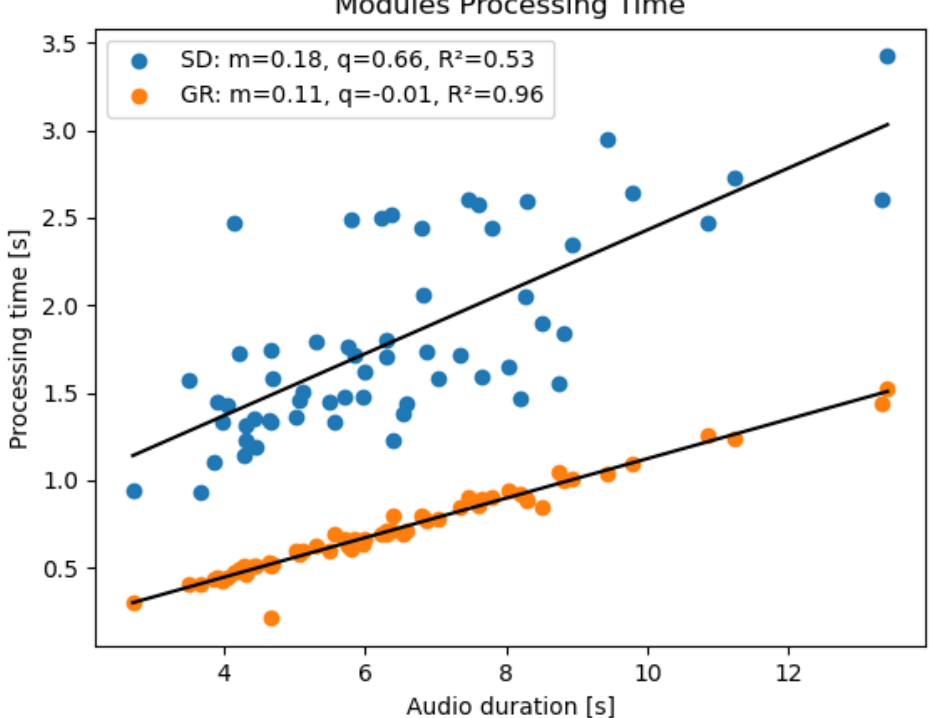
Figure 6. Processing time of the Speech Detector (blue) and Gender Recognition (orange) modules executed on Raspberry Pi in a real-time scenario. For each module, the slope, intercept and coefficient of determination (m, q, and R 2 respectively) are